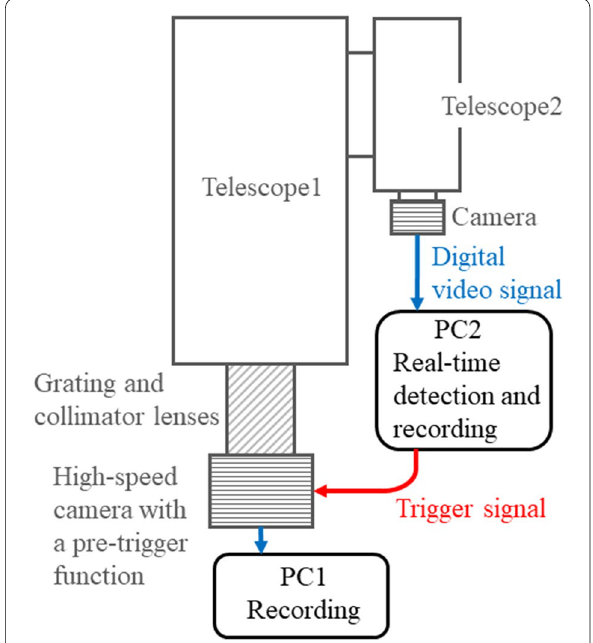
Fig. 18 A schematic diagram of a high-speed spectral camera proposed for observing lunar impact flashes. A flash is detected in real-time by PC2 in video signals from a normal camera attached to Telescope2. PC2 generates a trigger signal at the detection, then a high-speed camera attached to Telescope1 captures some successive images before, at, and after the